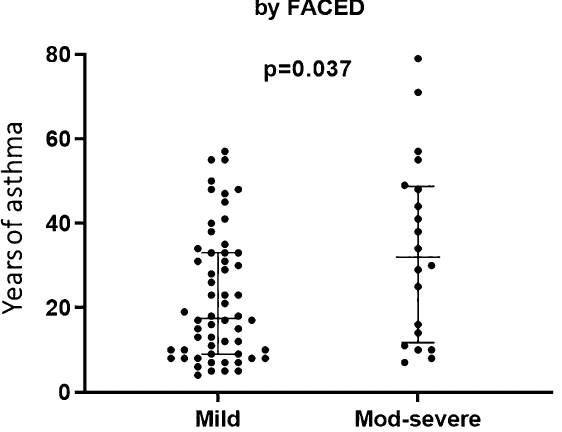
Figure 2. Asthma-year according to bronchiectasis severity assessed by FACED. Data expressed as median (IQR). Years of asthma 17.2 (9.1, 32.5) in mild vs 31.7 (12.0, 48.3) in moderate and severe bronchiectasis, p = 0.037.